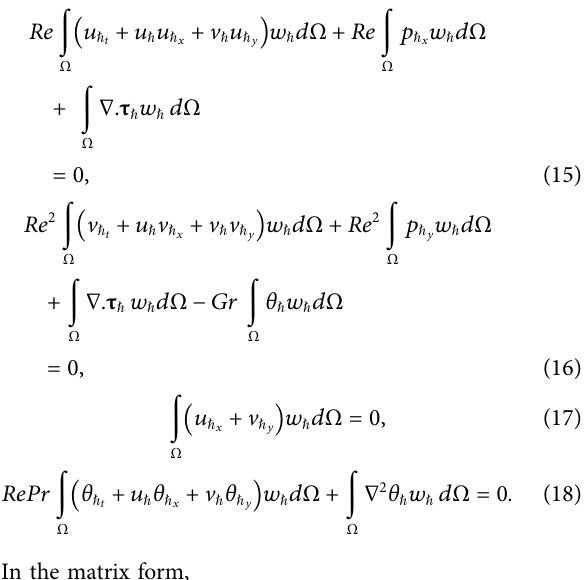
Frontiers in Physics |